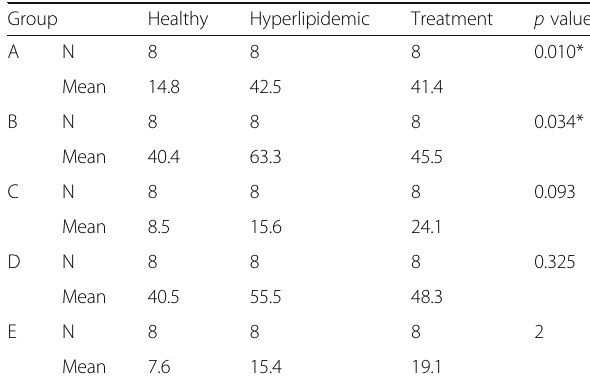
Table 2 Comparison contact angles formed on different discs in all periods ( p <